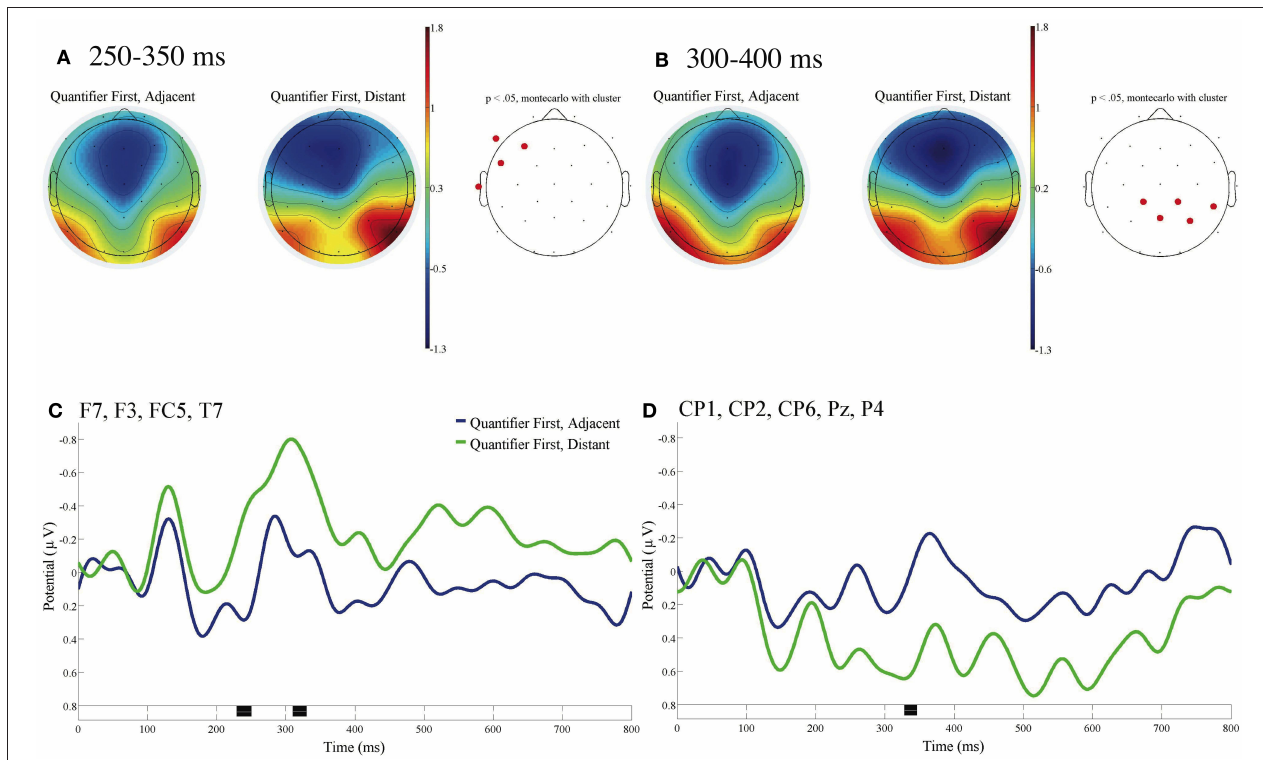
FIGURE 2 | ERPs time-locked to the onsets of the fifth phrases for Quantifier First in (A–D) with the baseline from 0 to 100 ms. (A) Mean topographies of the ERPs from 250 to 350 ms and (B) those from 300 to 400 ms for Adjacent (left) and Distant (right) conditions; the electrode sites at which significant differences were found by using the cluster-based permutation test ( p < 0.05) are depicted in red (Maris and Oostenveld, 2007). (C) Mean ERPs of the two conditions at the left frontal electrodes (F7, F3, FC5, and T7) and (D) Mean ERPs of the two conditions at the (right) parietal electrodes (CP1, CP2, CP6, Pz, and P4). Negativity is plotted upward, and the time windows during which significant differences were found by the cluster-based permutation test are indicated in black on the time axis in (C,D) .